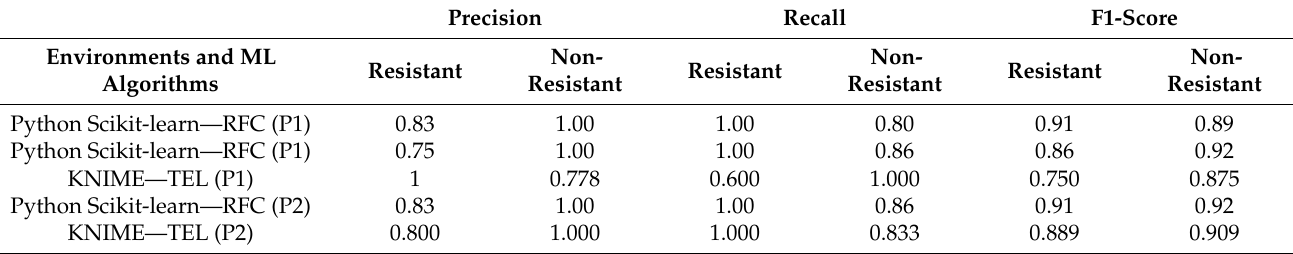
Table 3. Detailed ML modeling performance metrics for the resistant and non-resistant CRC post- operative individuals’